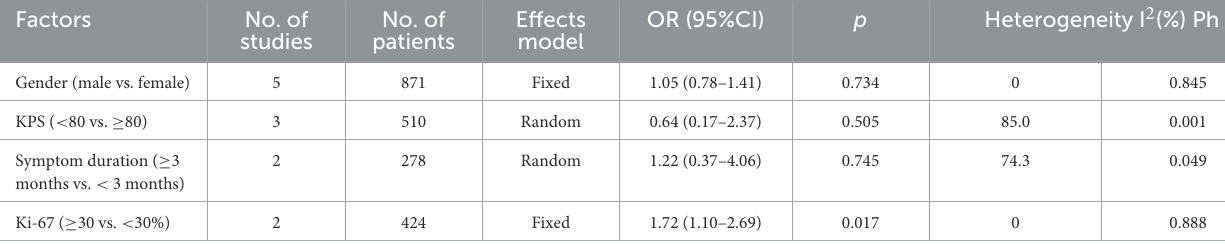
TABLE 3 Association between SII and clinicopathological features in patients with